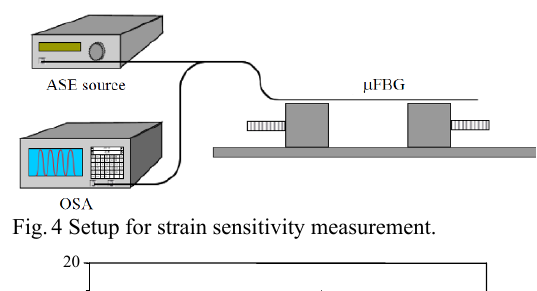
Fig. 4 Setup for strain sensitivity measurement.